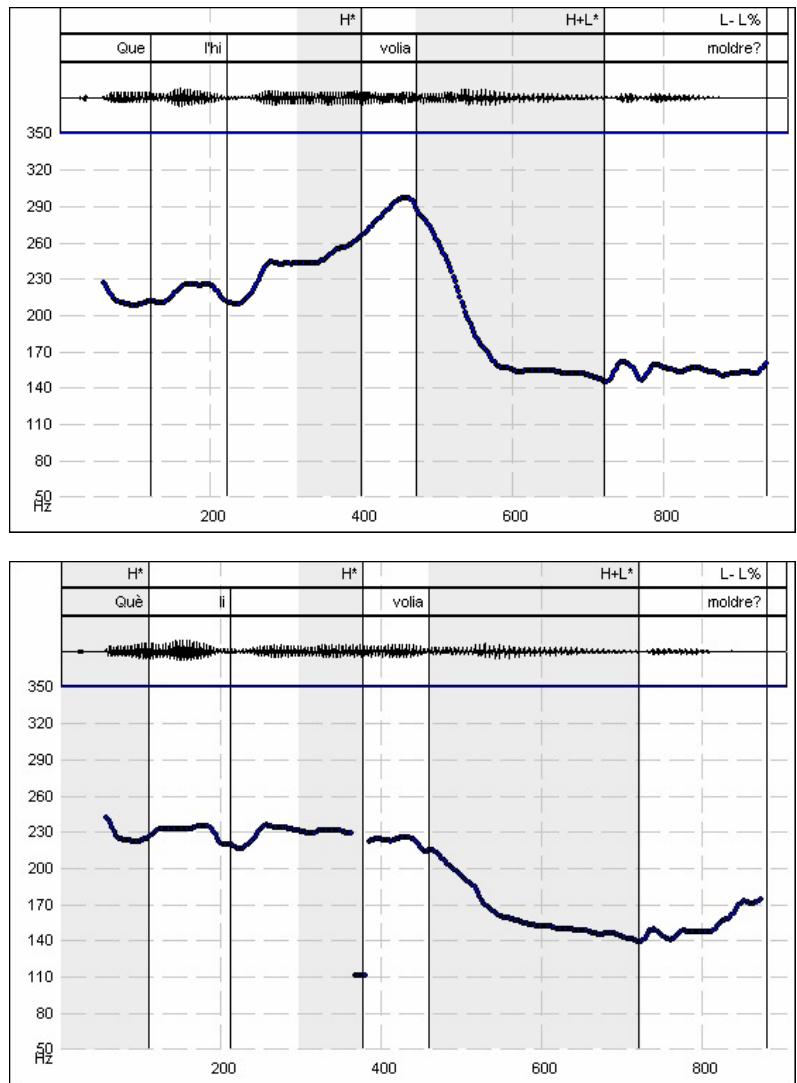
Figure 1. Waveforms and fundamental frequency contours of a yes-no question Que l’hi volia moldre?     d  (‘Did s/he want to grind it for him/her?’), upper panel, and a what-question Què li volia moldre? (‘What did s/he want to grind for him/her?’)     d  , bottom panel. Accented syllables are